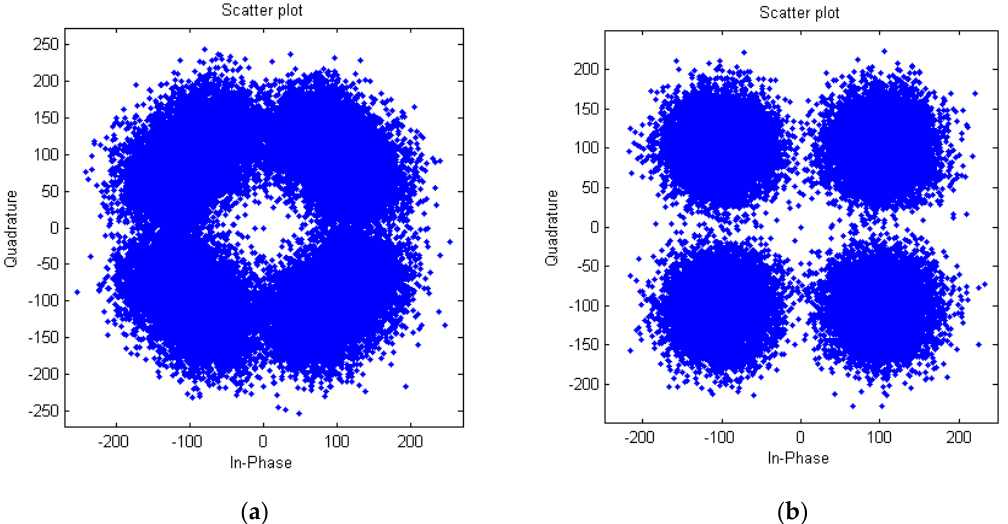
Figure 4. ( a ) Constellation of the MR-OFDM with the CFO effect; ( b ) Constellation of the MR-OFDM after CFO compensation over the Gaussian channel.